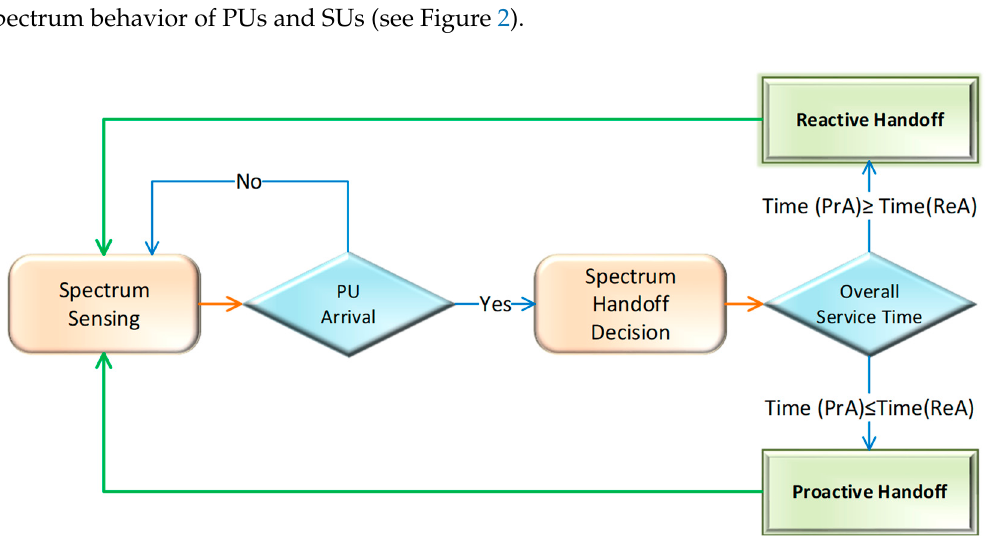
Figure 2. Cognitive radio user behavior on the arrival of primary user (PU).